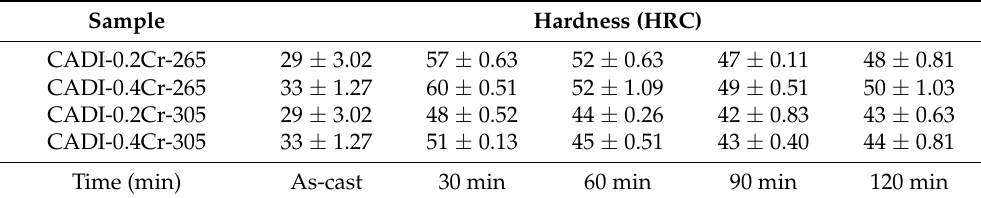
Table 4. Hardness (HRC), as a function of the austempering parameters for the CADIs evaluated.